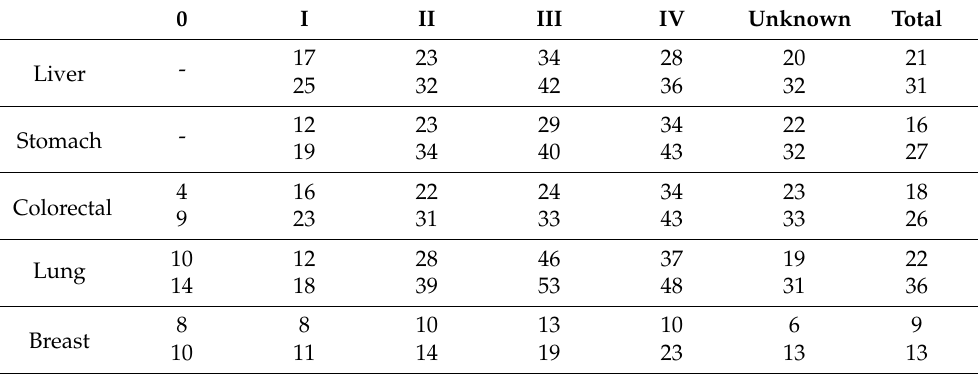
Table 4. Hospitalization duration per-patient (upper: median, lower: mean).